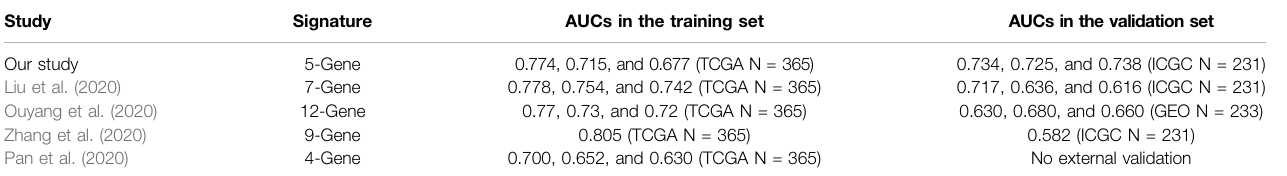
TABLE 1 | Comparison of the risk model and other models.